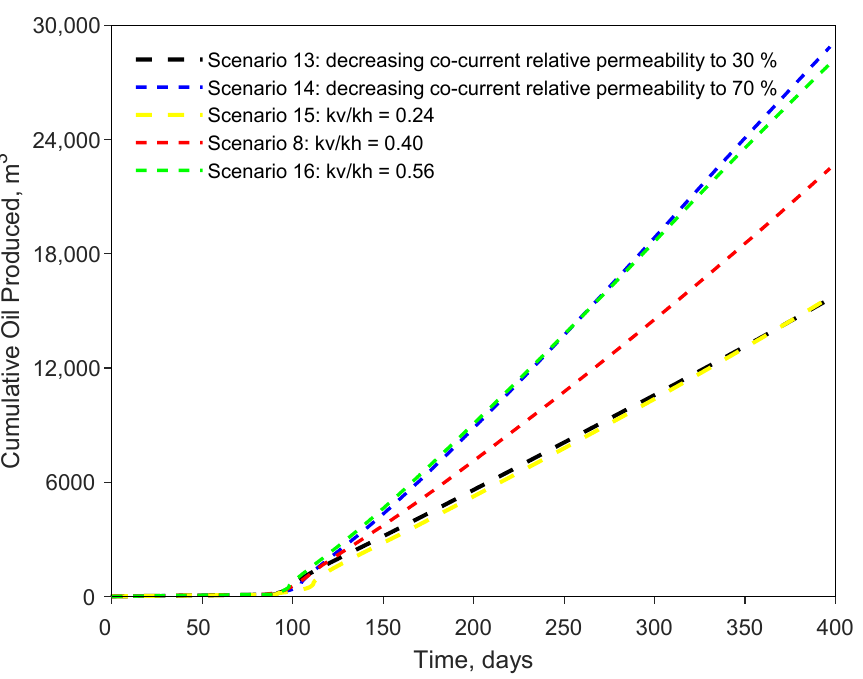
Figure 15. Cumulative oil production of scenarios 8, 13, 14, 15 and 16 under varying countercurrent relative permeability values and vertical permeabilities using kv/kh ratios.